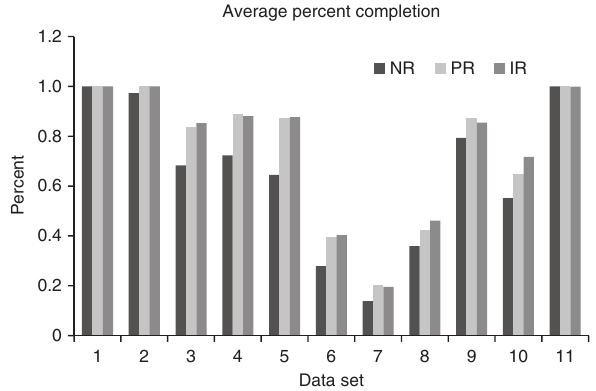
Figure 8. Average Percentage of Completion by Data Set and Recognition Type. NR, group with no recognition; PR, plan recognition group; IR, intent recognition